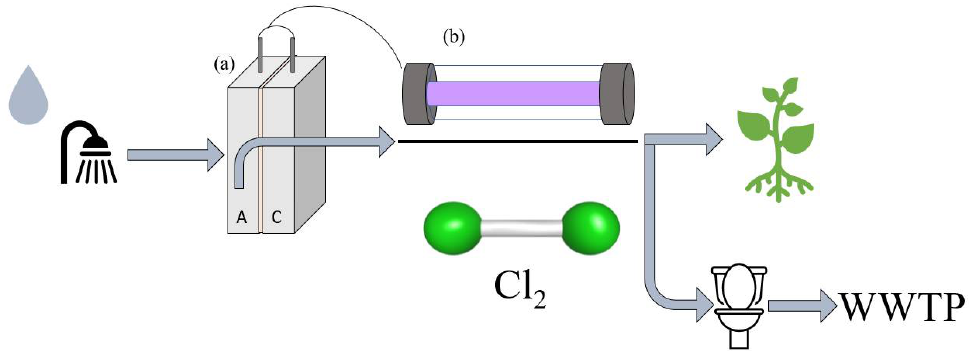
Figure 6. Schematic of the proposed on-site treatment plant. ( a ) MFC reactor; ( b ) disinfection stage, with UV lamp or chlorination. The effluent can be used for toilet flushing or for urban food crop cultivation. WWTP: wastewater treatment plant.